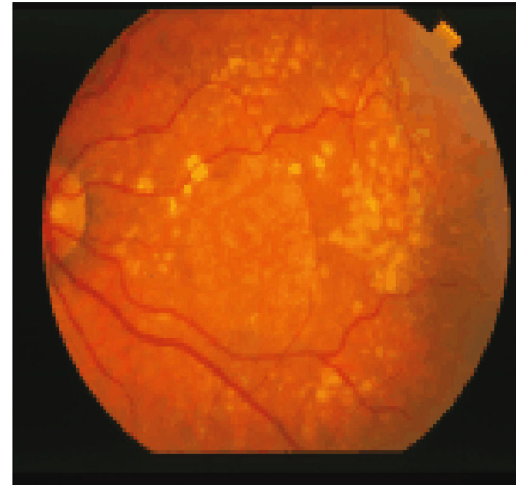
Figure 2: Glaucoma image.